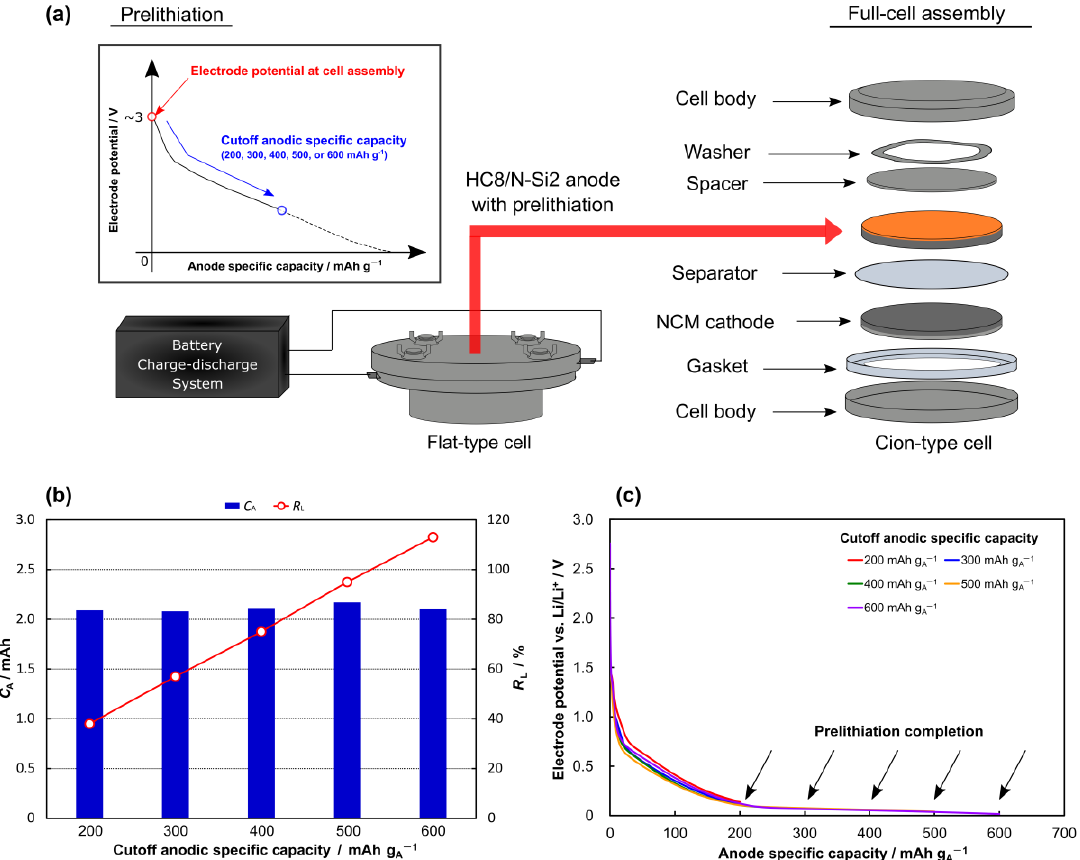
Figure 4. Prelithiation of the HC8/N-Si2 composite anode used in a full-cell configuration: ( a ) illustrations of the prelithiation strategy and full-cell assembly; ( b ) anode capacity ( C A ) and prelithiation rate ( R L ) corresponding to various cutoff anodic specific capacities; ( c ) electrode potential as a function of anodic specific capacity during prelithiation at different cutoff anodic specific capacities.